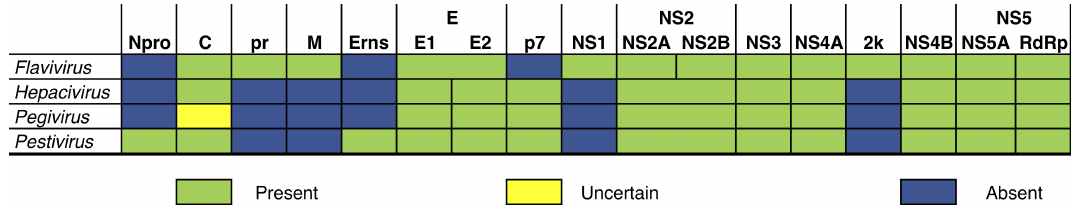
Figure 2. Genome structure comparison between the four genera of Flaviviridae ( Flavivirus , Hepacivirus , Pegivirus and Pestivirus ), showing the 14 partitions that can be found in the genomes of the family. The columns on this table are not proportional to partition